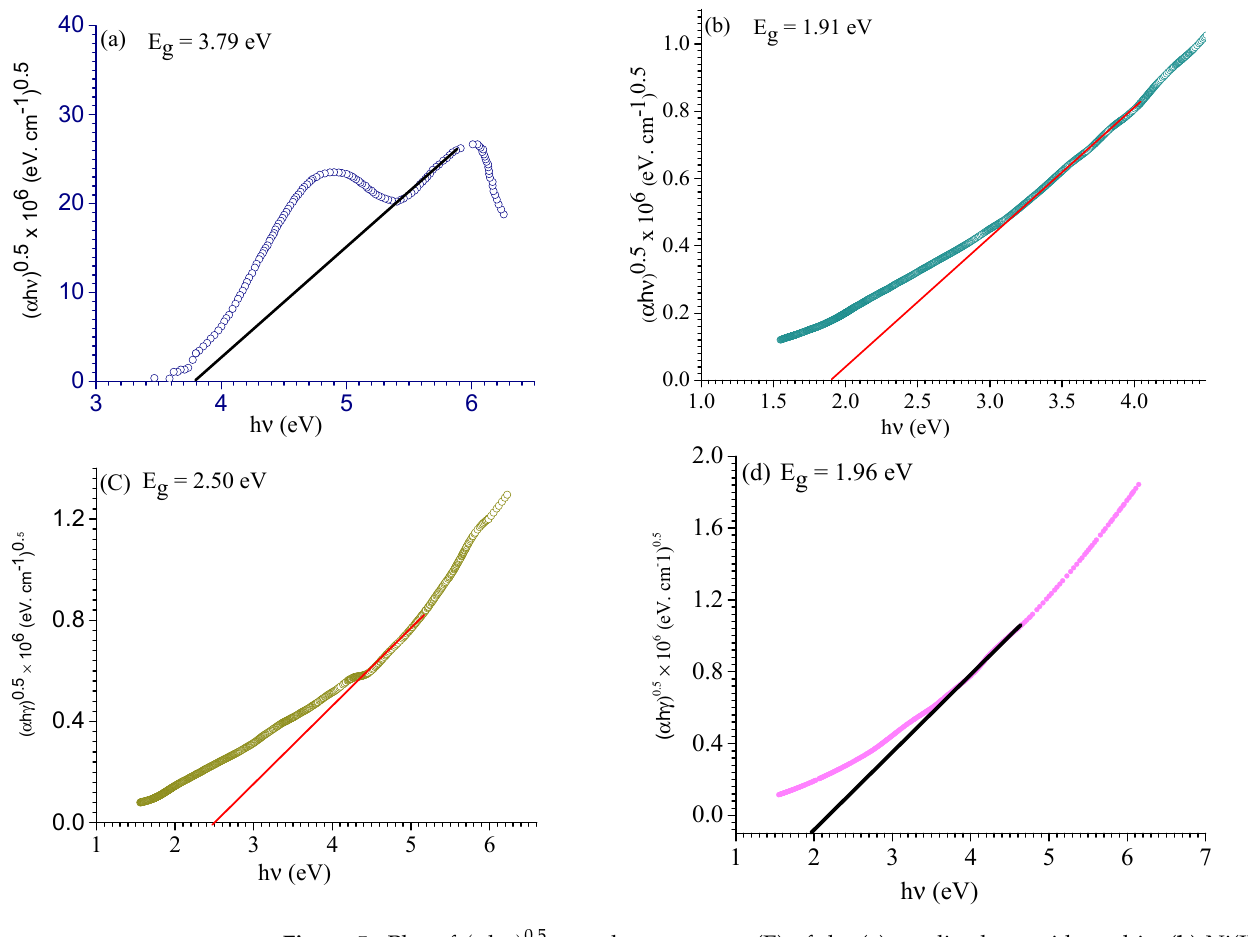
Figure 5. Plot of ( α h ν ) 0.5 vs. photon energy (E) of the ( a ) azodicarbonamide and its ( b ) Ni(II), ( c ) Cu(II), and ( d ) Zn(II)